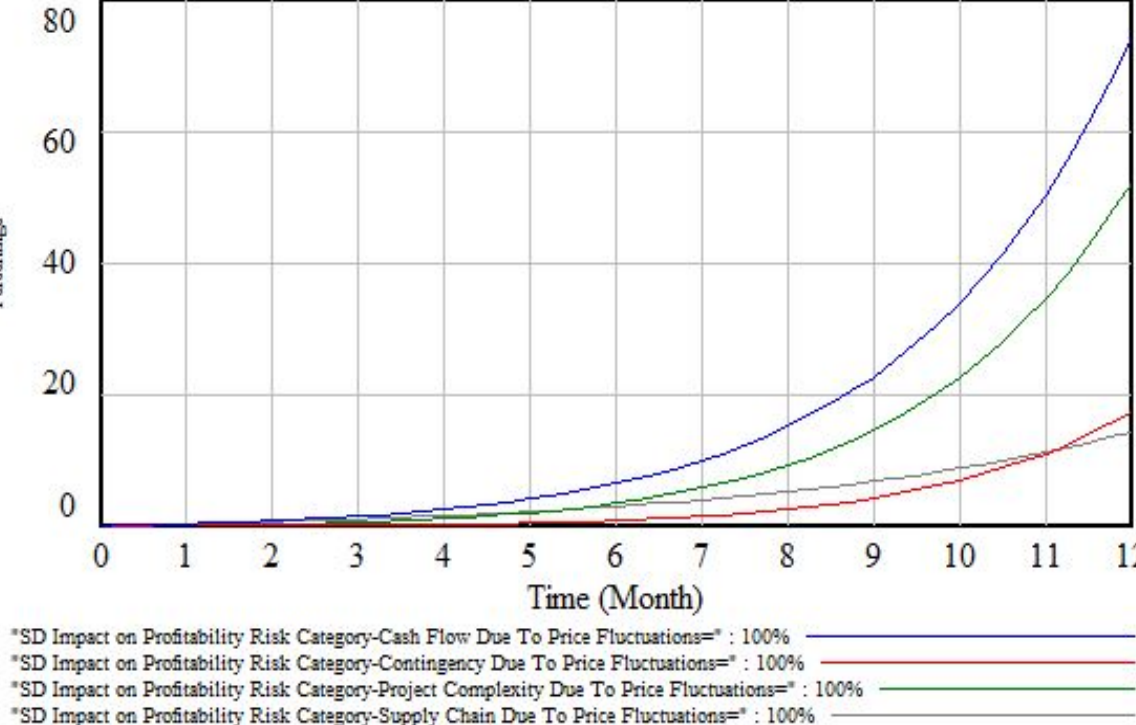
Figure 11. Dynamic integrated impacts on profitability risk categories over time (price fluctuations = 50%).